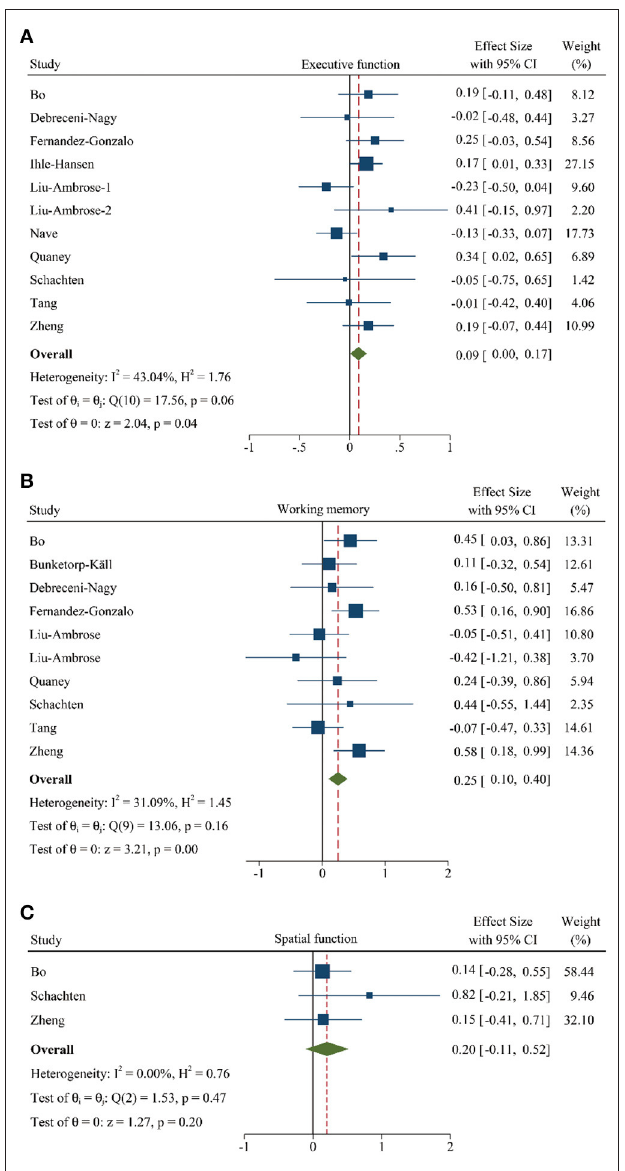
FIGURE 4 | Forest plot of meta-analysis in the PA on specific cognitive domains. (A) Meta-analysis of effect of PA on executive function. (B) Meta-analysis of effect of PA on working memory. (C) Meta-analysis of effect of PA on spatial function. Positive values of pooled effect size represented that PA improved cognitive performance. Abbreviation: CI, confidence interval; PA, physical